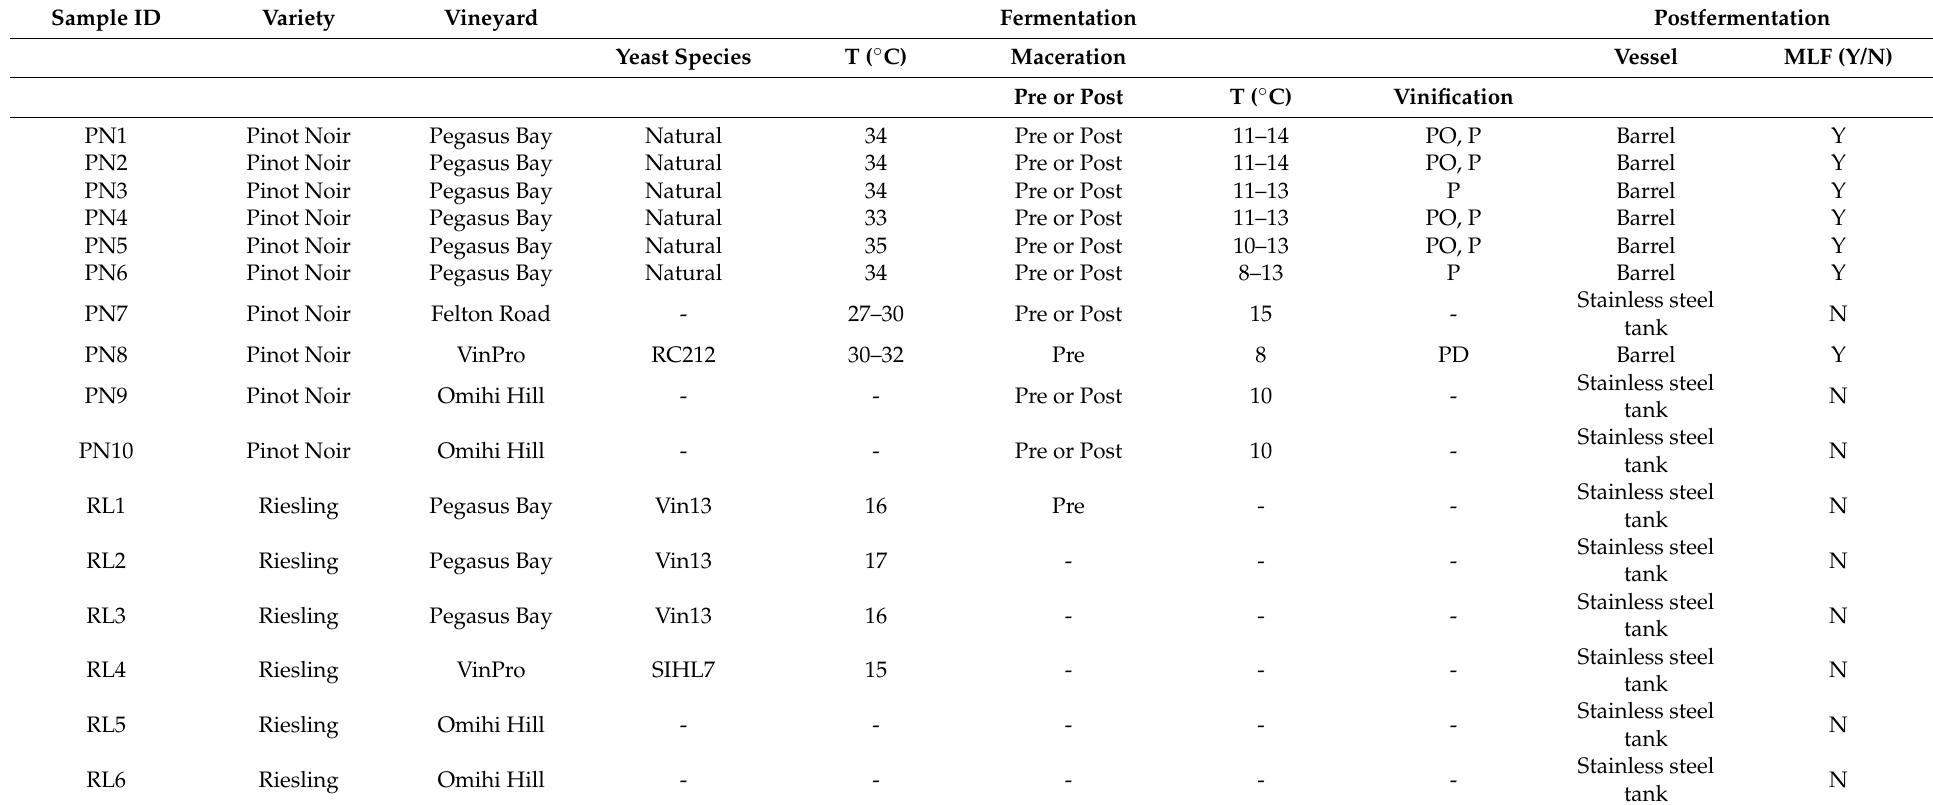
Table 1. Information summary of the studied lees